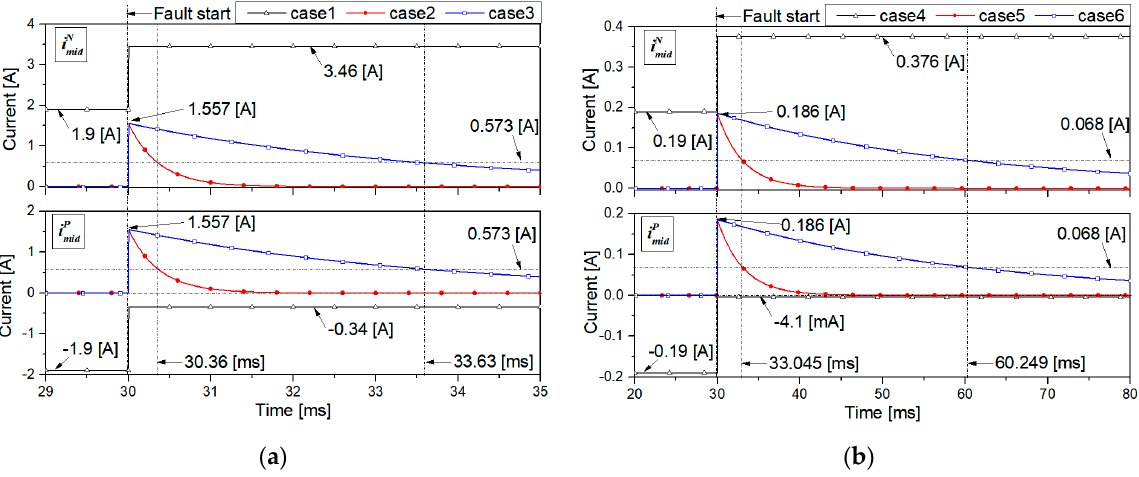
Figure 14. Current waveforms flowing through the negative ( (cid:1861) (cid:3040)(cid:3036)(cid:3031)(cid:3015) ) and positive ( (cid:1861) (cid:3040)(cid:3036)(cid:3031)(cid:3017) ) resistors in the mid ‐ point ground system: ( a ) Case with 100 Ω as the resistance; ( b ) Case with 1000 Ω as the resistance.